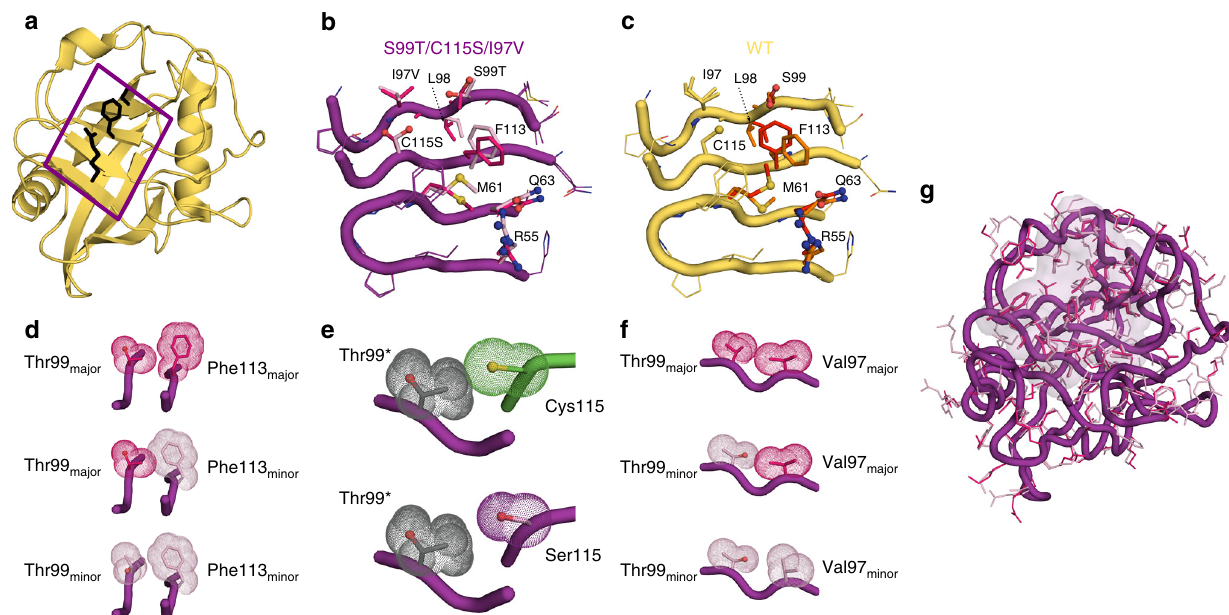
Fig. 4 Structural basis of the increased protein dynamics from room-temperature X-ray crystallography on rescue mutants. a X-ray structure of CypA (2CPL 40 ) with the active-site residues Arg55, Ser99, and Phe113 shown in black stick representation. The boxed area indicates the extended dynamic network shown in more detail in b and c . b Major and minor side chain conformations are shown for S99T/C115S/I97V (5WC7, 1.43 Å, see Supplementary Table 1) in purple and pink, respectively. The populations are fl ipped relative to wild-type CypA (3K0N, 1.4 Å) 8 ( c ), where major/minor states are shown in red and orange, respectively. The Phe113-in state corresponds to the major WT state and the minor S99T/C115S/I97V state. Correspondingly, the Phe113- out state corresponds to the minor WT state and the major S99T/C115S/I97V state. d , e , f Less steric hindrance due to the reduced size of side chains in rescue mutants facilitates the interconversion between major and minor conformations. Coupling between the conformation of Thr99 and Phe113 ( d ) and Val97 and Thr99 ( e ) are necessary to relieve clashes. The C115S ( f , purple) mutation allows for a transition between Thr99 conformations (gray indicates morph between the major in minor state labeled Thr99*) without clash, in contrast to the bulkier Cys residue (green). g CONTACT analysis 28